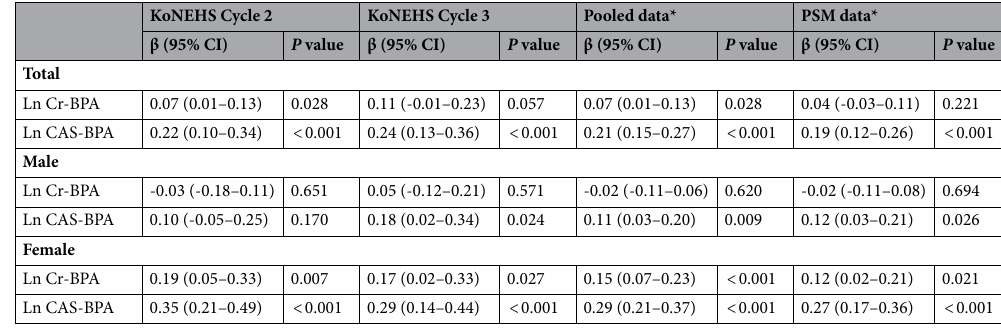
Table 3. Association between BMI and urinary bisphenol A. Analysis according to the quartiles of CAS-BPA. Adjusted for age, sex, household income, smoking, alcohol consumption, and physical activity. CI, confidence intervals; PSM, propensity score matching; BMI, body mass index; CAS-BPA, CAS-applied urinary BPA. *Unweighted results.